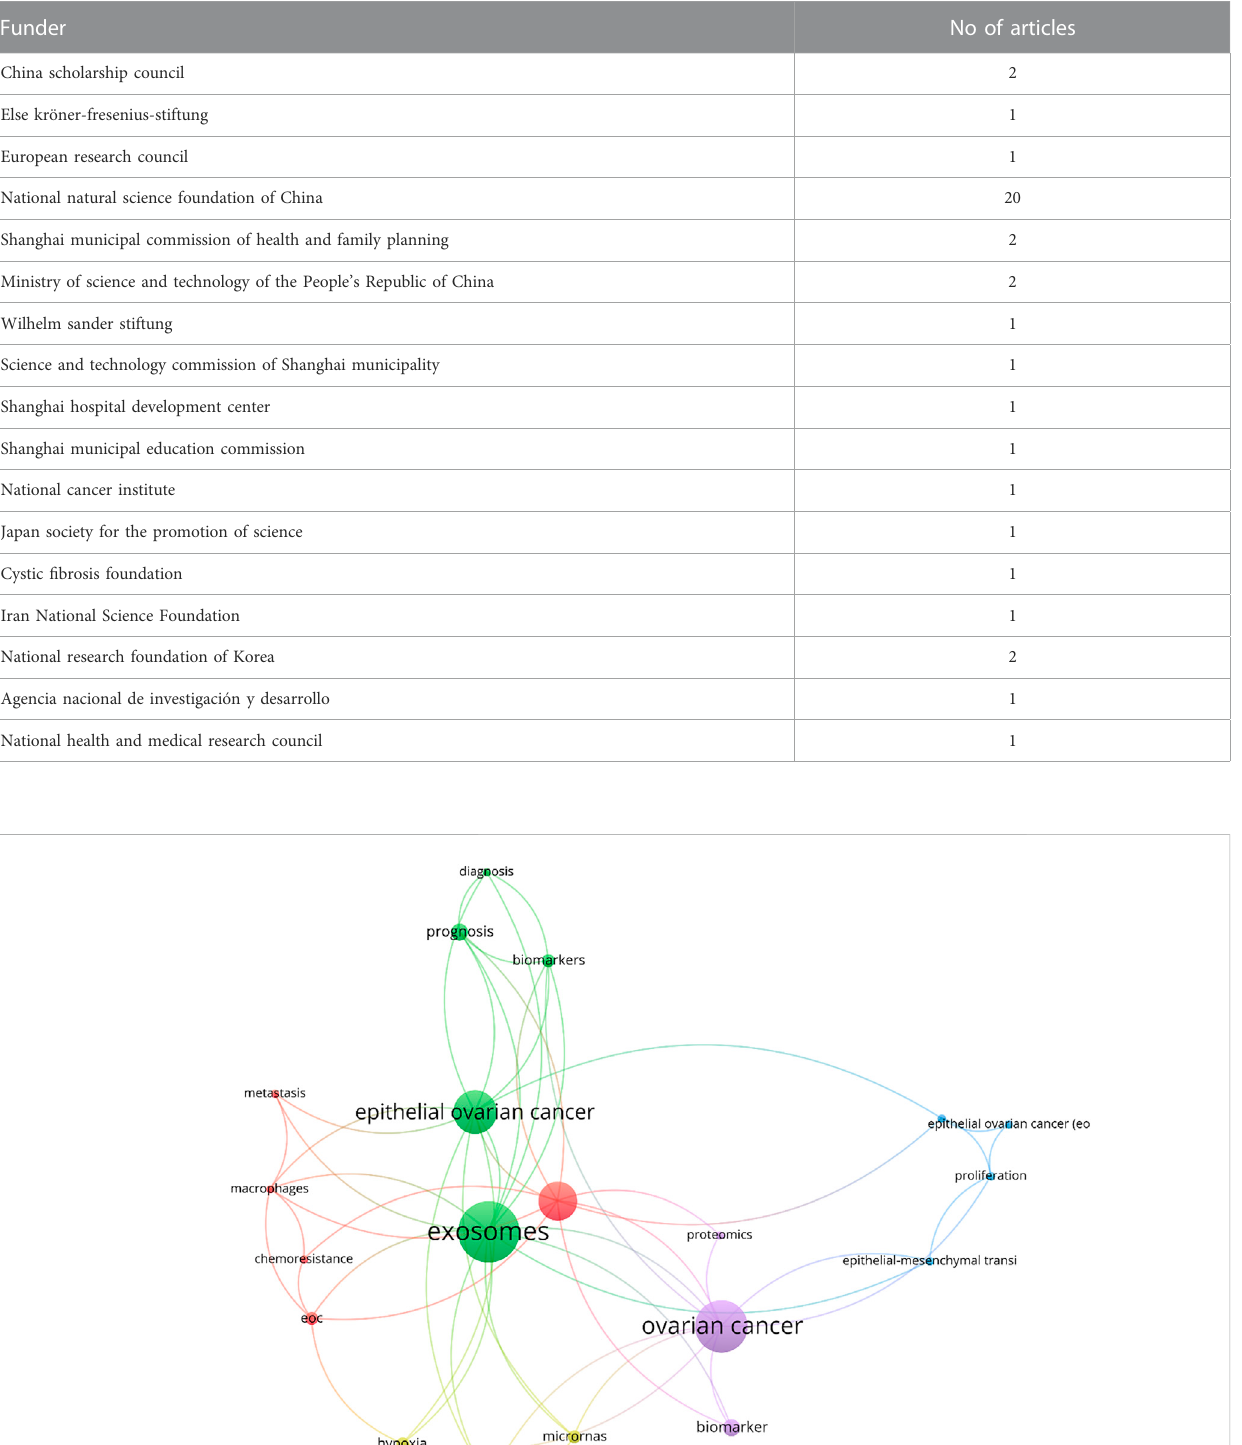
TABLE 5 Sponsors of research in the fi eld of exosome and EOC. Funder